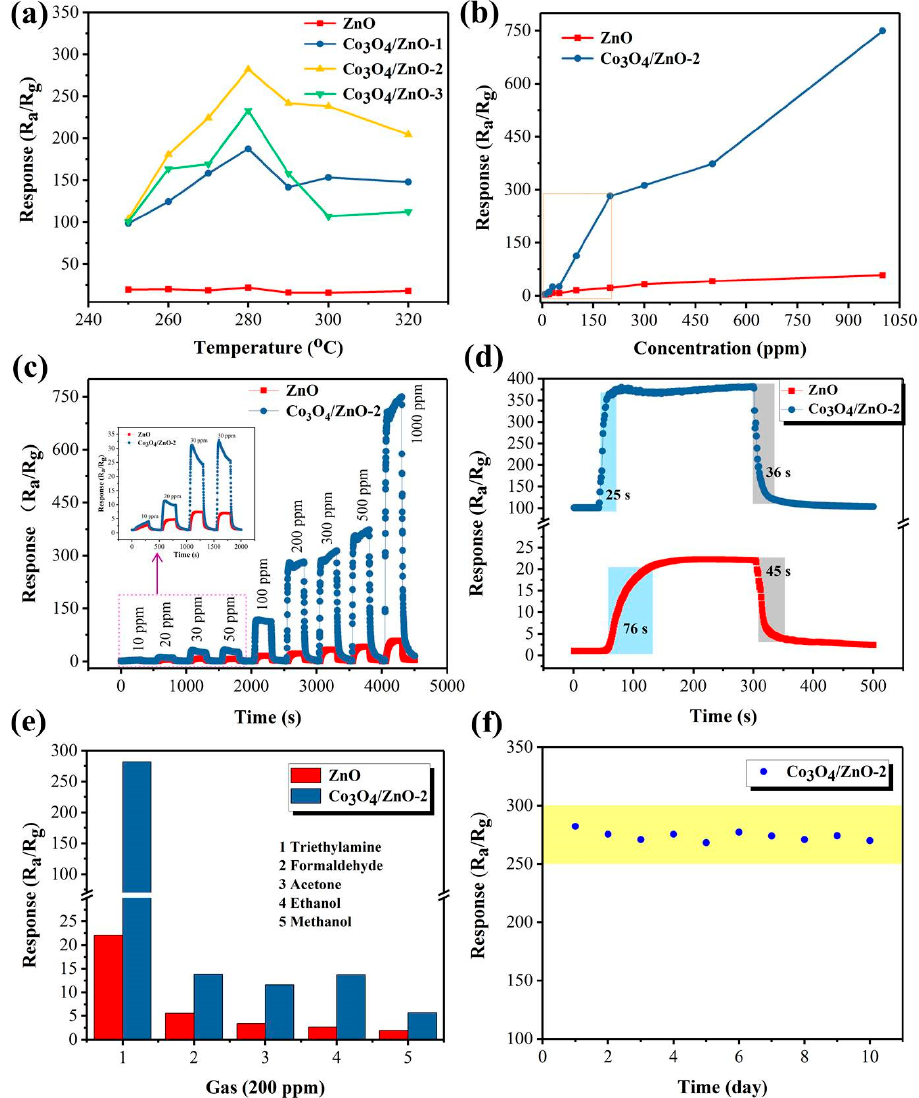
Figure 6. ( a ) Responses of the sensors to 200 ppm triethylamine (TEA) at different temperatures; ( b ) concentration-dependent responses of the sensors toward TEA at 280 °C; ( c , d ) dynamic and transient response–recover curves of the sensors toward TEA at 280 °C, where d is 200 ppm TEA; ( e ) the responses of the sensors to 200 ppm various gases at 280 °C; ( f ) stability research of the Co3O4/ZnO-2 sensor to 200 ppm TEA at 280 °C (define R a /R g as the response of the sensor). Concentration-response correlation tests were performed on two representative ZnO and